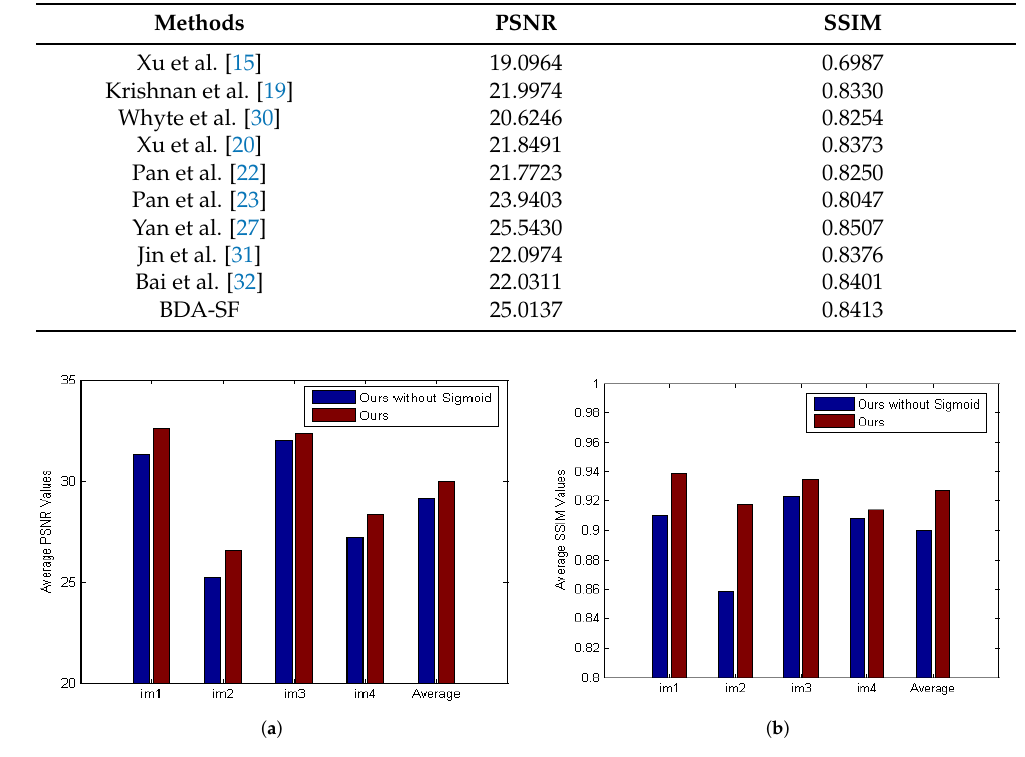
Figure 13. Quantitative evaluation results of BDA-SF.